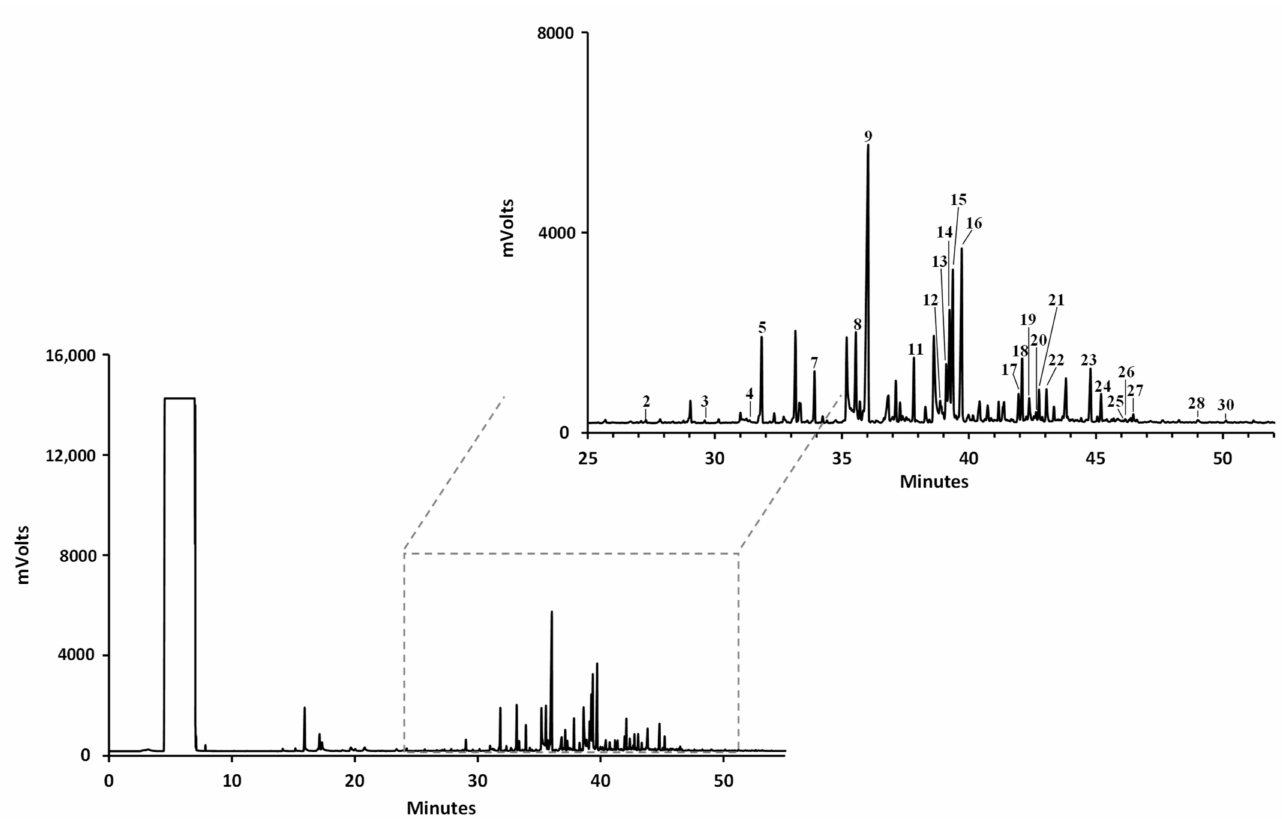
Figure 2. Representative GC-FID chromatogram of the fatty acid profile of Microcosmus squamiger methanol